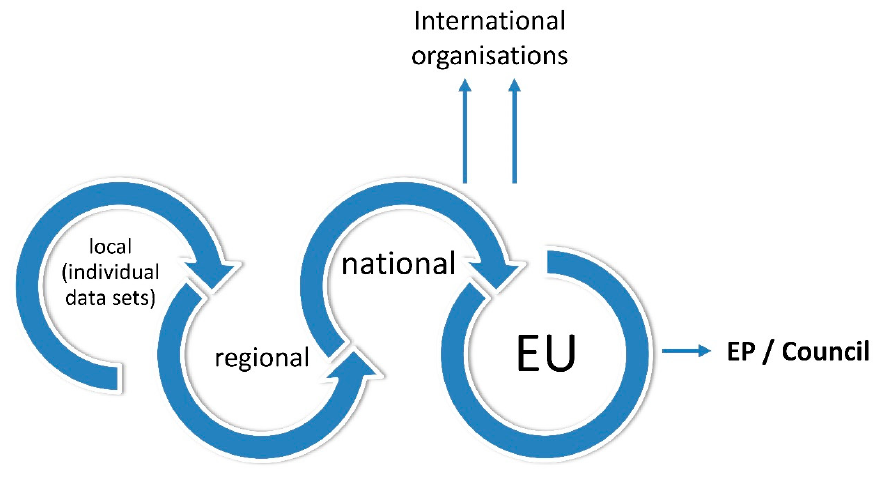
Figure 1. A data flow process for the implementation of environmental legislation in the EU. Adapted by [53 ].